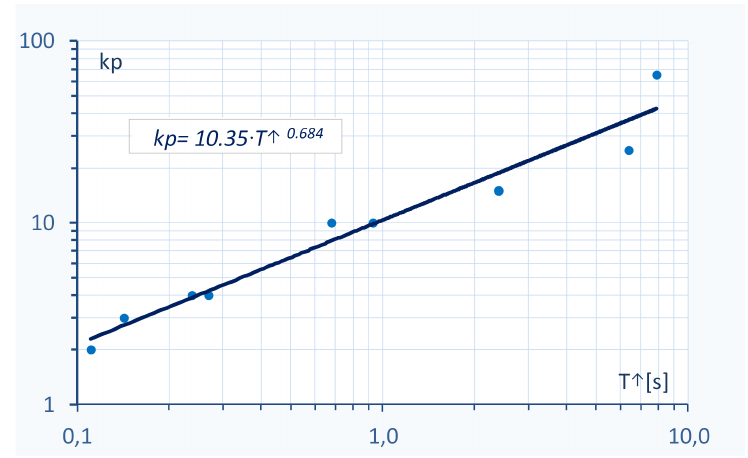
Figure 10. The proportional gain, k p , versus the time constant, T ↑ .